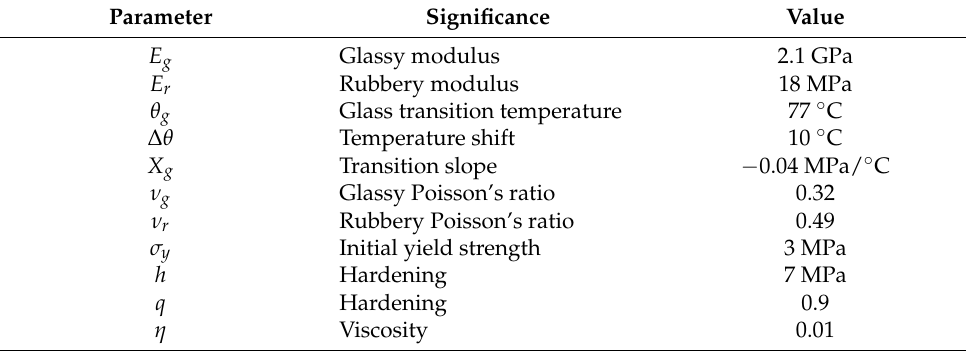
Table 2. Model constants for the amorphous